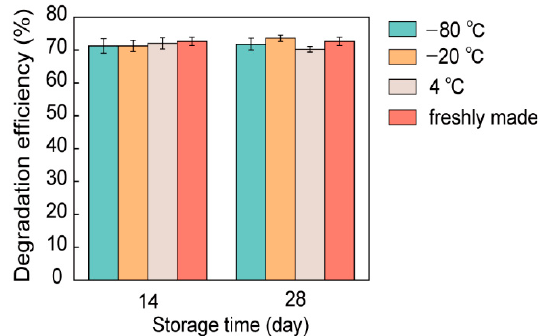
Figure 7. Assessment of the photocatalytic degradation performance of engineered living materials (ELMs) stored under different conditions. The concentration of trypan blue after 24 h of treatment was compared with the initial concentration to assess the trypan blue degradation efficiency. The concentration was determined by comparing it to a trypan blue calibration curve generated based on Abs 583 nm . The ELMs could retain their photocatalytic degradation capacity for up to 28 days when stored at temperatures lower than 4 ° C. The data are presented as mean ± s.d ( n = 2).